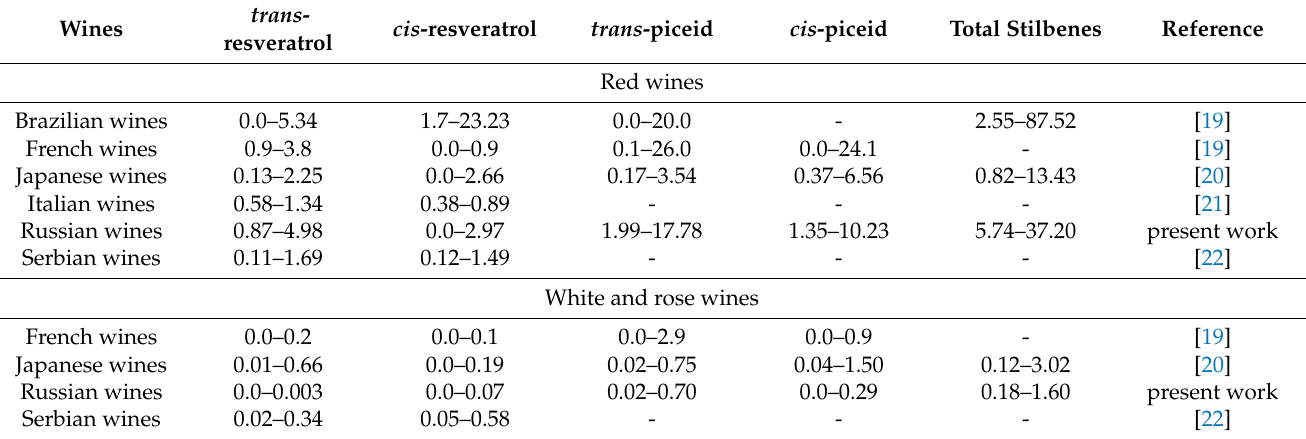
Table 1. The content of stilbenes in wines of different origins